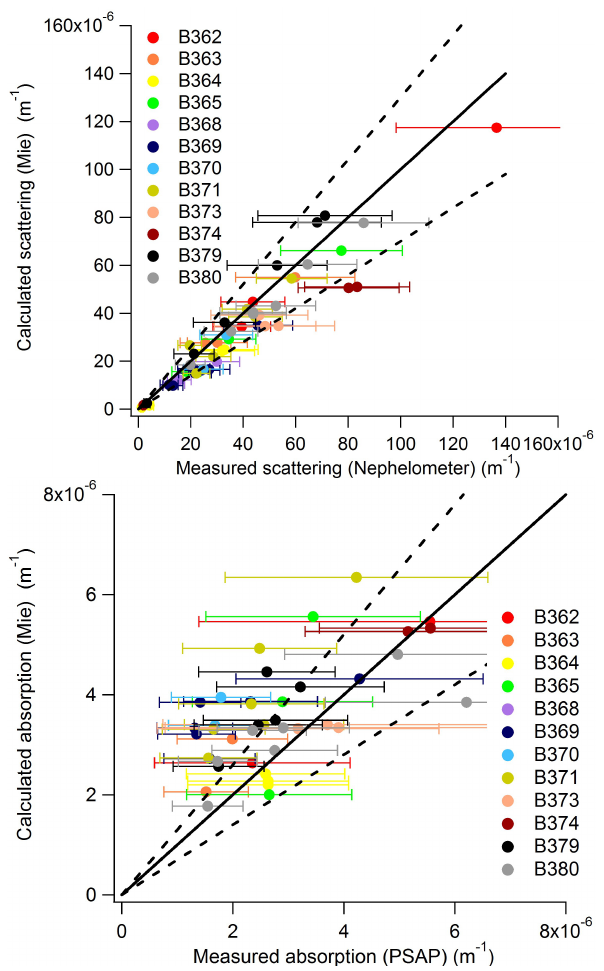
Fig. 8. Calculated versus measured scattering (a) and absorption (b) at 550nm averaged for each run in every flight from EUCAARI- LONGREX. The one-to-one line is indicated (solid black) as are the ± 30% tolerances (dashed lines). Error bars show the uncertainty in measured scattering assuming a measurement uncertainty of 20% for the nephelometer and in-run variability ranging from 12–35% in (a) and the uncertainty in measured absorption assuming a mea- surement uncertainty of 30% for the PSAP and in-run variability ranging from 16–47% in (b)